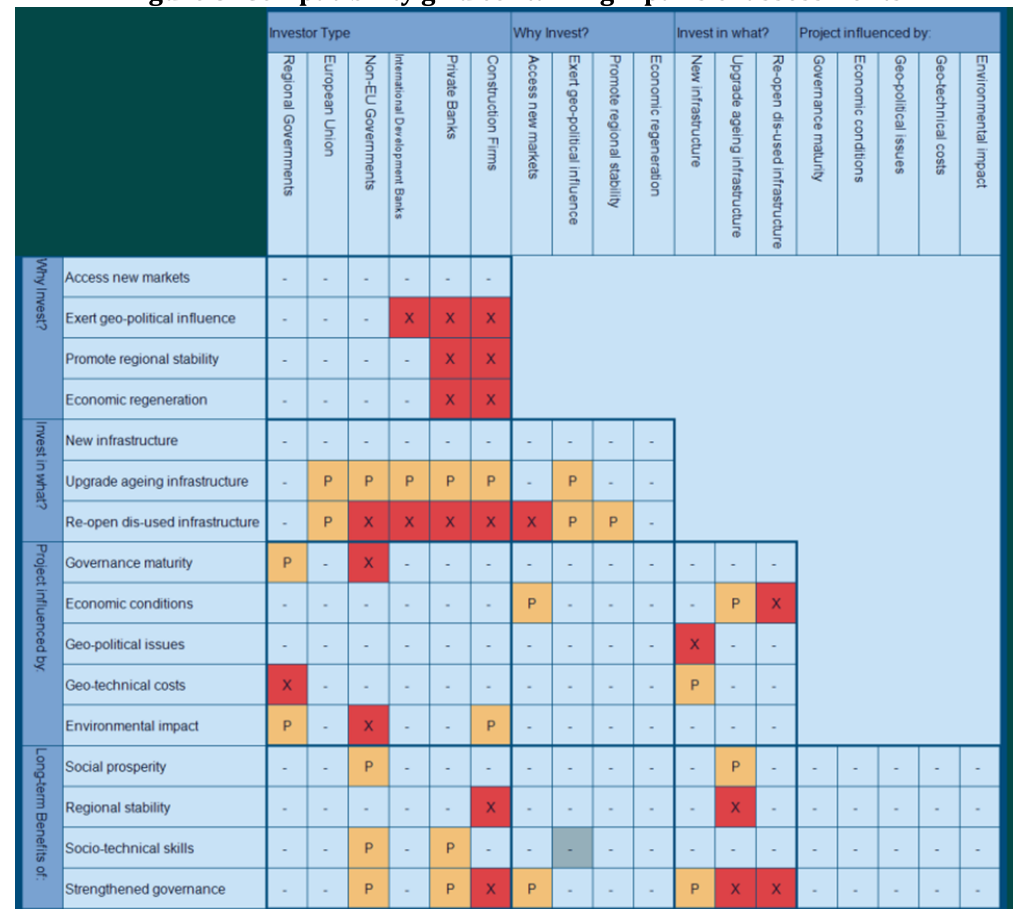
Figure 3: Compatibility grid containing X pairs of assessments